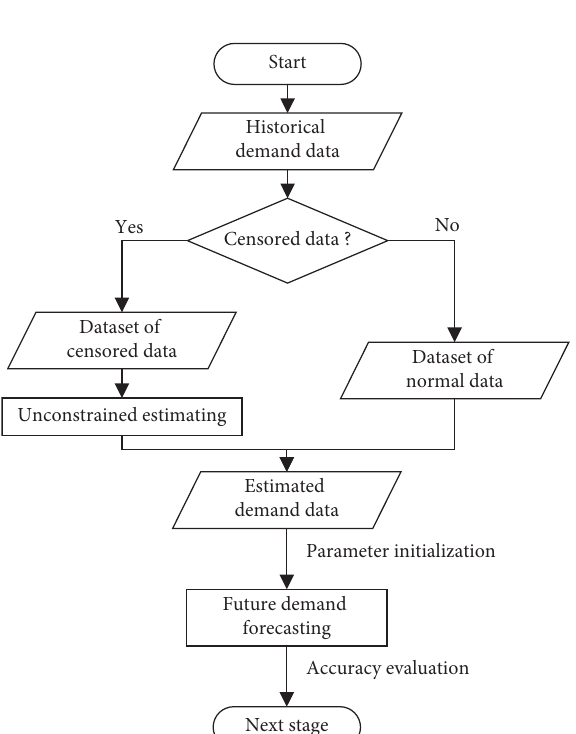
Figure 4: Unconstrained demand forecast process.